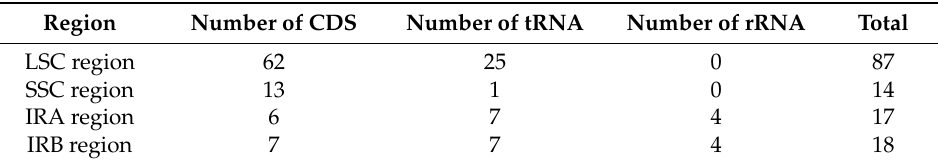
Table A1. The number of genes in the Q. acutissima cp genome.